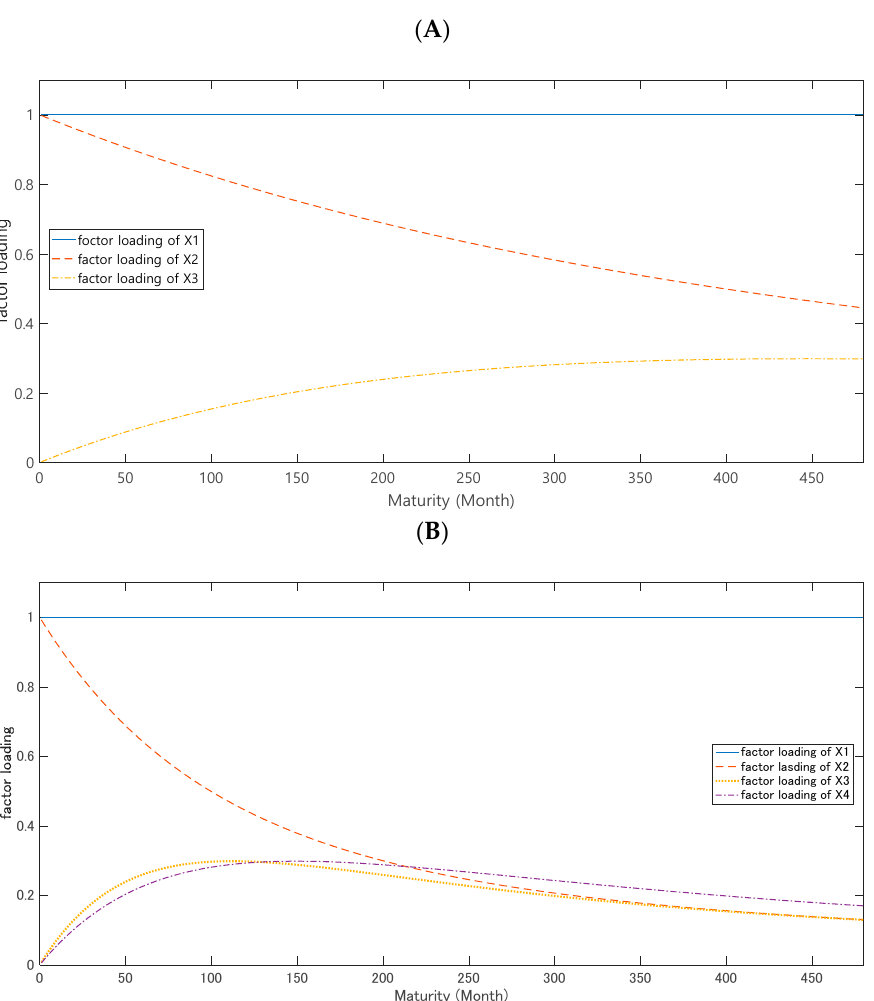
12 Christensen et al. (2011) estimated each 𝜆 of the DNS and the AFNS model separately; however, the values were almost the same.